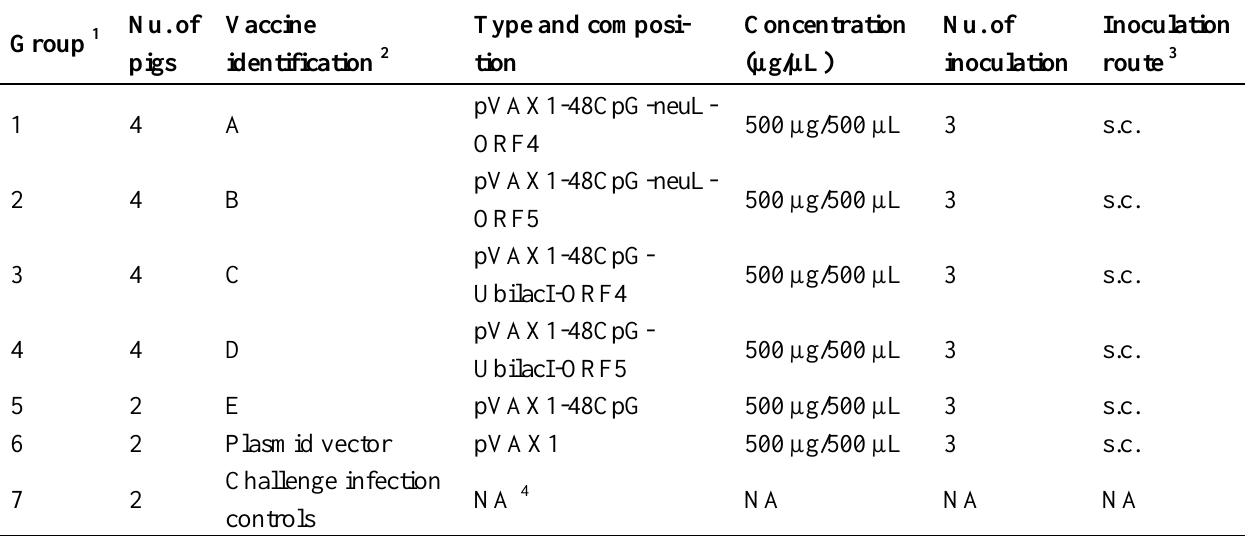
Table 1. Porcine respiratory and reproductive syndrome (PRRS) DNA vaccines used in the